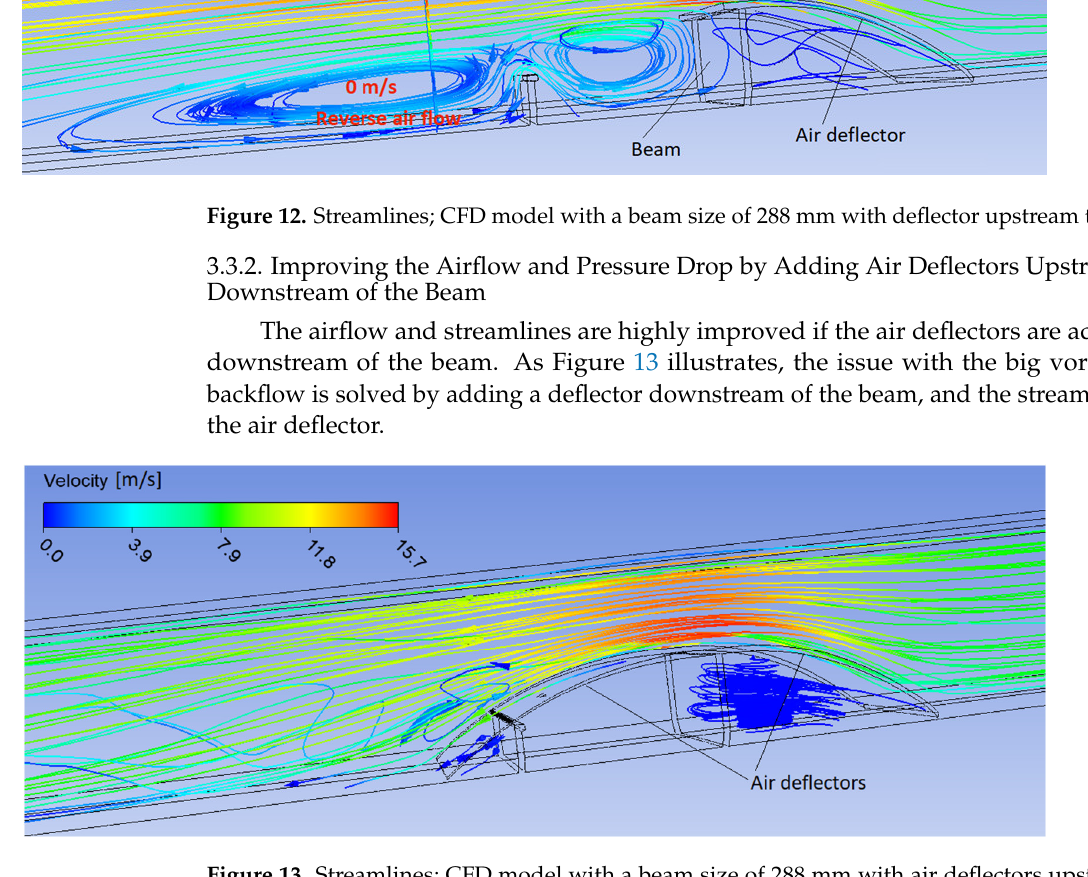
Figure 14. Air velocity; beam without deflectors; longitudinal section in centerline (CFD model with a beam size of 288 mm, inlet air velocity of 7.9 m/s). Figure 15. Air velocity, beam with deflector upstream the beam; longitudinal section in the center- line (CFD model with a beam size of 288 mm, inlet air velocity of 7.9 m/s). The airflow increases to 15 m/s in the area of the beam due to the reduced cross sec- tion, but the airflow follows the shape of the deflector, and the velocity goes down to the constant value of about 8 m/s when the cross section increases. The velocity of the airflow is almost constant downstream of the deflector in the centerline, as seen in Figure 16. There is a small area close to the side bulkheads of the ventilation duct downstream of the air deflector where the air velocity is going down below 4 m/s, but only for a short distance. Overall, the air deflectors upstream and downstream of the beam have a big positive im- pact on the airflow, and the total pressure drop is improved from 133 Pa to about 9.6 Pa. In addition, the noise and vibration could be improved by canceling the high turbulences and by removing the big vortices.